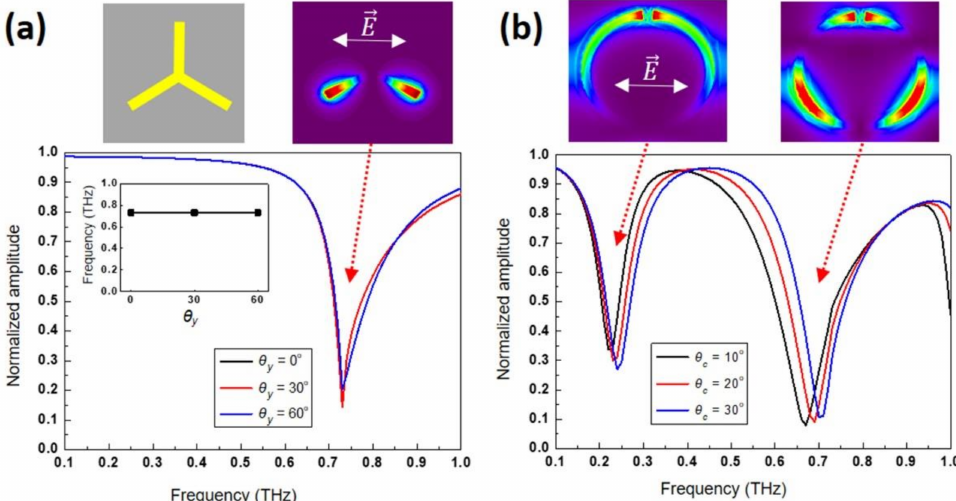
Figure 2. ( a ) Simulated THz amplitude spectra in the arrays of Y-shaped meta-atoms at the rotation angles of θ y = 0 ◦ , 30 ◦ , and 60 ◦ . The inset shows the values of resonance frequency. The upper image shows the near electric field distribution at the resonance frequency at the rotation angle of θ y = 0 ◦ . ( b ) Simulated THz amplitude spectra in the arrays of C-shaped SRR meta-atoms at the angular gaps of θ c = 10 ◦ , 20 ◦ , and 30 ◦ . The upper images show the near electric field distributions at the resonances appearing near the frequencies of 0.25 and 0.7